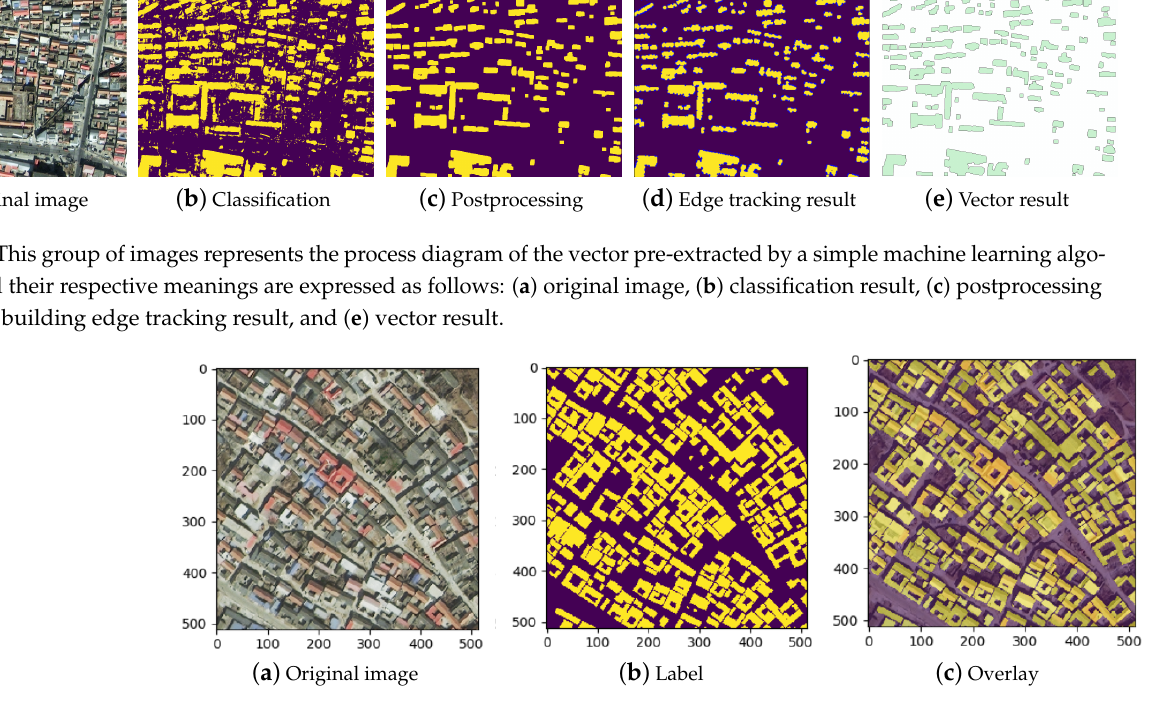
Figure 3. Sample segmentation